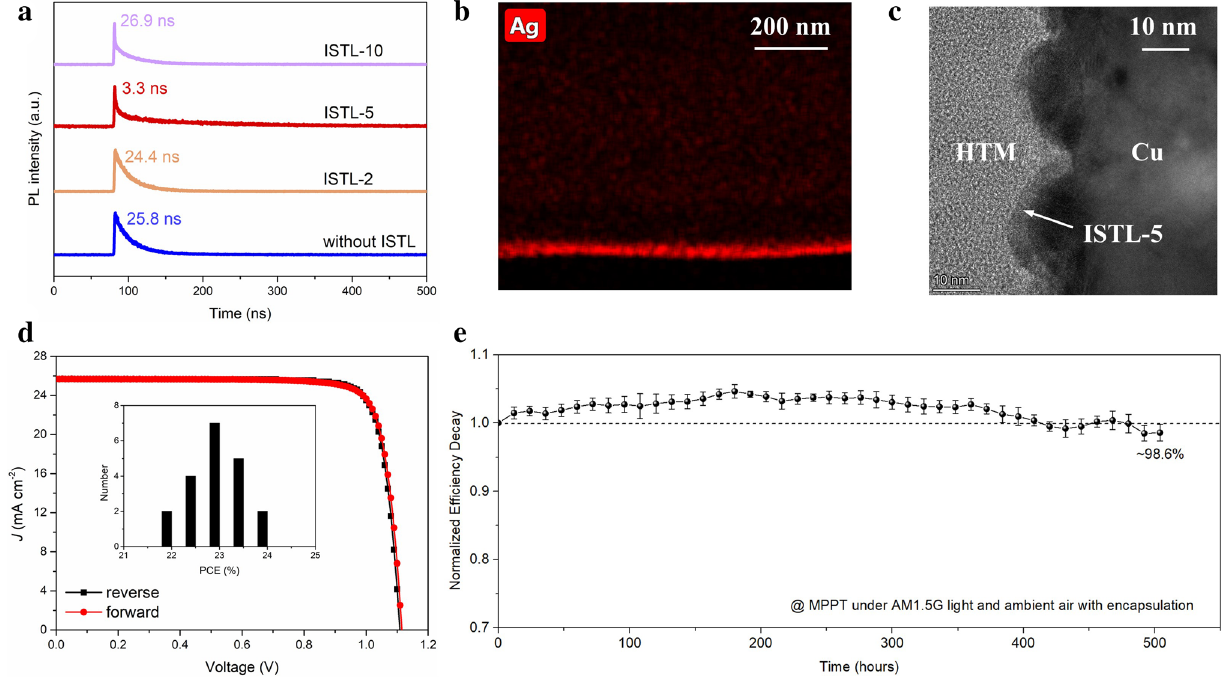
Fig. 4 Performances of the devices with ISTL (AgI) and Cu anode. a The TRPL results of glass/perovskite/spiro-OMeTAD/ISTLs/Cu. b The TEM image (inset: HR-STEM image of Cu/ISTL-5/HTM structure) and c corresponding EDS mapping of Ag element. d The J–V curves of the champion device with ISTL-5 (Inset: the histogram of average PCE value of twenty devices with ISTL-5). e The operational stability of the encapsulated devices with ISTL-5. The scale bar is 200 nm. The TEM and HR-STEM sample was prepared by FIB technique and the Pt and C was acted as protective multilayer to exclude the effect of the environment. The initial PCEs are 22.0 ± 0.2%, and the error bars denote standard deviations for five individual